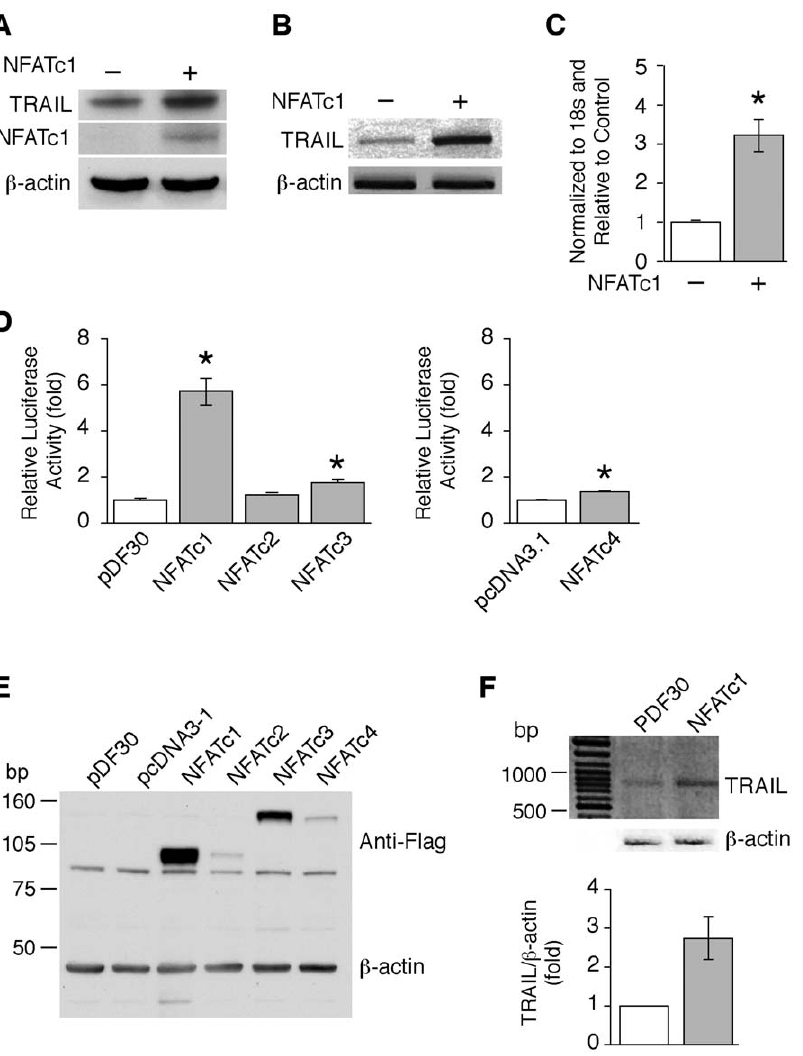
Figure 3. Overexpression of NFATc1 increased TRAIL expression in HT29 and Caco-2 cells. HT29 cells were transfected with either the control plasmid (pDF30) or Flag-tagged NFATc1. At 48 h posttransfection, cells were harvested. ( A ) Expression of TRAIL and NFATc1 protein was detected by Western blot using anti-TRAIL or anti-Flag antibodies. Membranes were reprobed with anti- b -actin antibody to assess loading. ( B and C ) Total RNA was extracted, and RT-PCR ( B ) or real time PCR ( C ) performed. (Data shown as mean 6 standard error of the mean. *, P , 0.05, vs. control plasmids). ( D ) Caco-2 cells were transfected with a proximal 1371 bp TRAIL promoter construct together with either control plasmid pDF30, pCDNA3.1 or Flag-tagged NFATc1, NFATc2, NFATc3 or NFATc4. At 48 h posttransfection, cells were harvested; luciferase activity was then assayed. All results were normalized for transfection efficiency using the pRL-Tk-luc plasmid (Promega). (Data shown as mean 6 standard error of the mean. *, P , 0.05, vs. control plasmids). ( E ) Expression of NFATc1, NFATc2, NFATc3 and NFATc4 in Caco-2 cells was confirmed by Western blot using anti-Flag antibody. ( F ) Caco-2 cells were transfected with control plasmid, pDF30, or Flag-tagged NFATc1. At 48 h posttransfection, total RNA was extracted, and RT-PCR performed using primers to human TRAIL and b -actin. TRAIL signals from three separate experiments were quantitated densitometrically and expressed as fold-change with respect to b -actin (Data shown as mean 6 standard error of the mean).